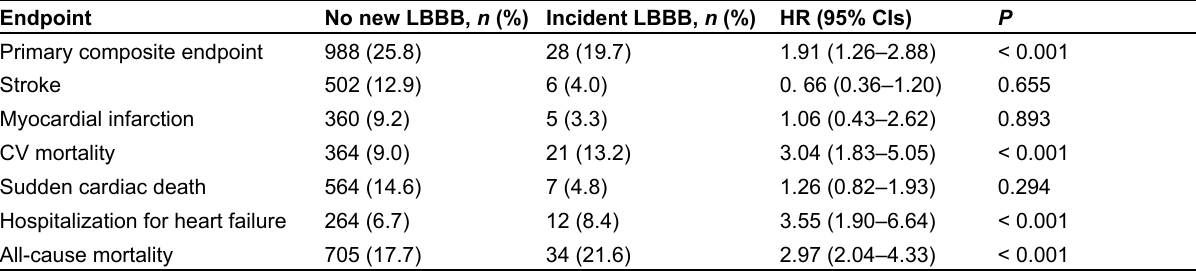
Table 4. Association of incident LBBB with clinical endpoints in multivariate Cox regression